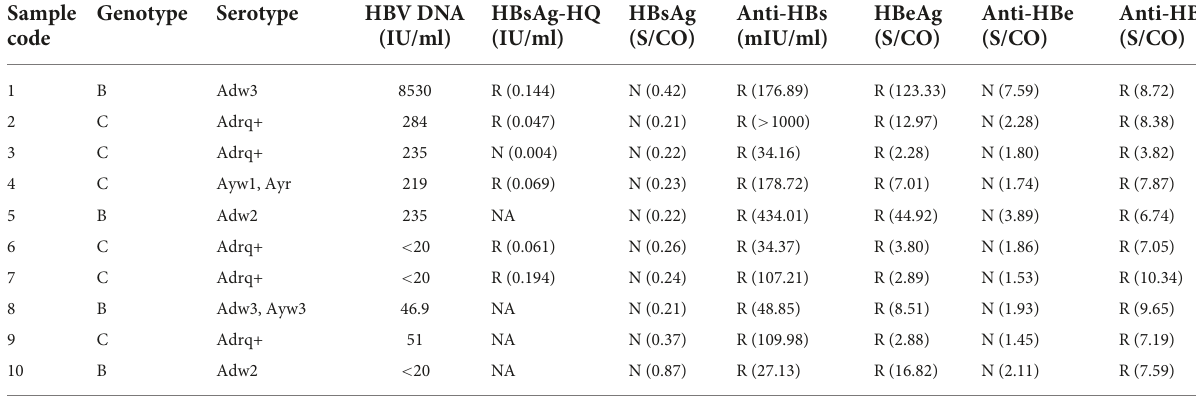
TABLE 1 Characteristics of the 10 HBsAg-/anti-HBs+/HBeAg+